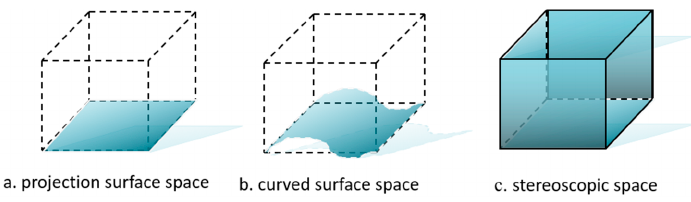
Figure 2. Diagrams for the logical abstraction of meteorological space.